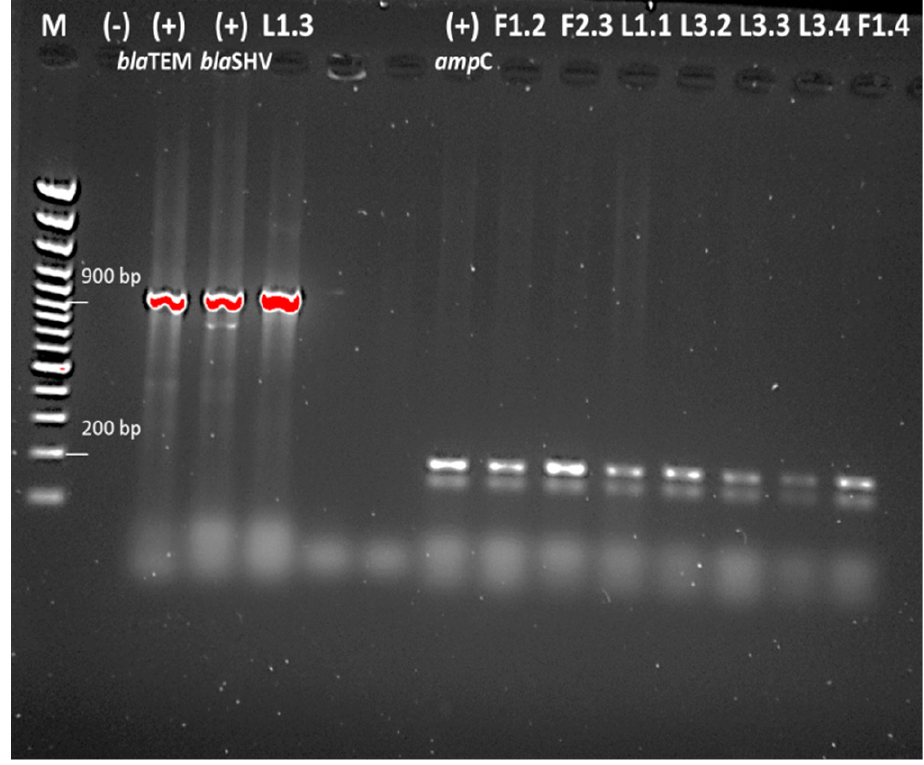
Figure 3. Detection of amp C β‐ lactamases gene and bla TEM and bla SHV β‐ lactam ‐ resistance genes.